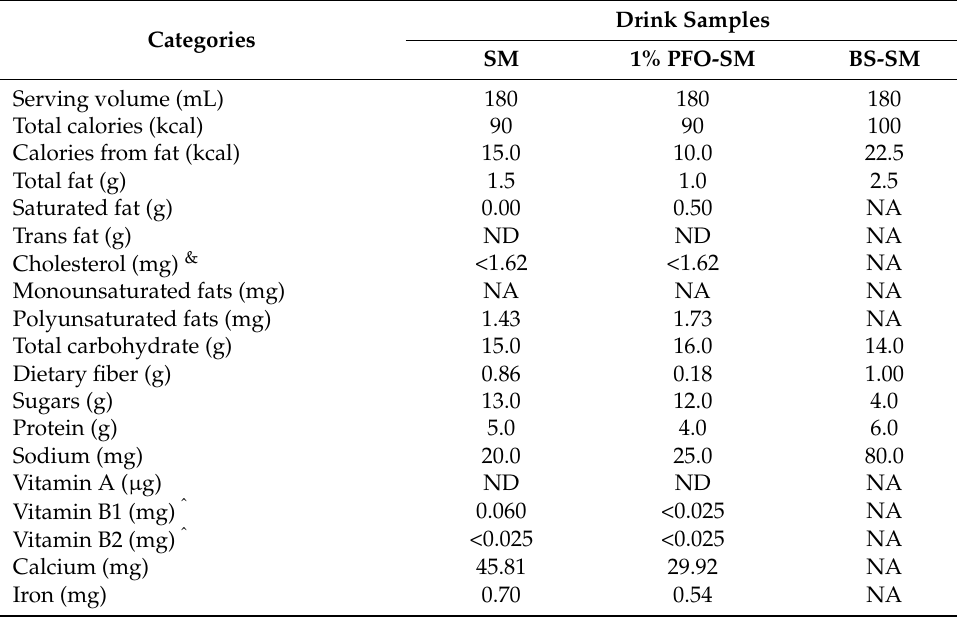
Table 1. Nutritional data of SM, 1% PFO-SM, and BS-SM